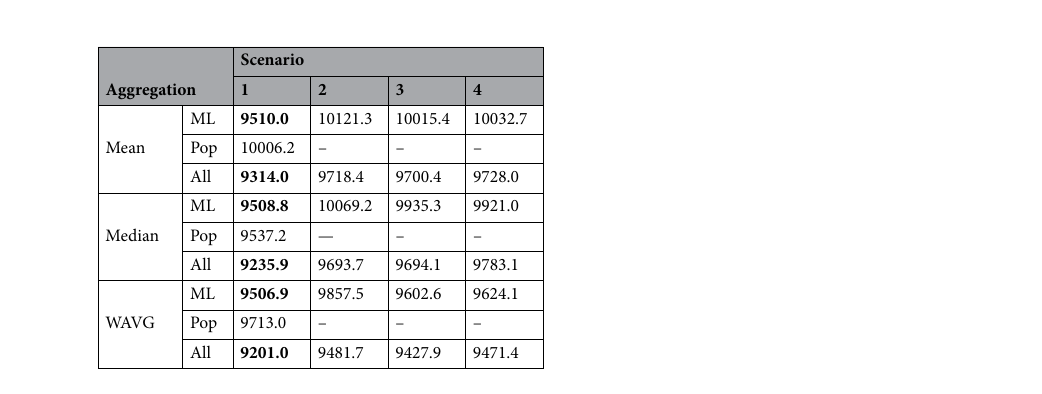
Table 5. RMSE obtained in each scenario according to each form of aggregation, for the Spain case in the test split. Lowest error values are in [bold].